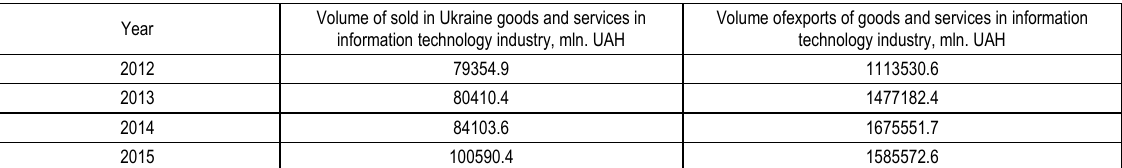
Table 1. Ratio of exports and the total volume of produced goods and services in information technology